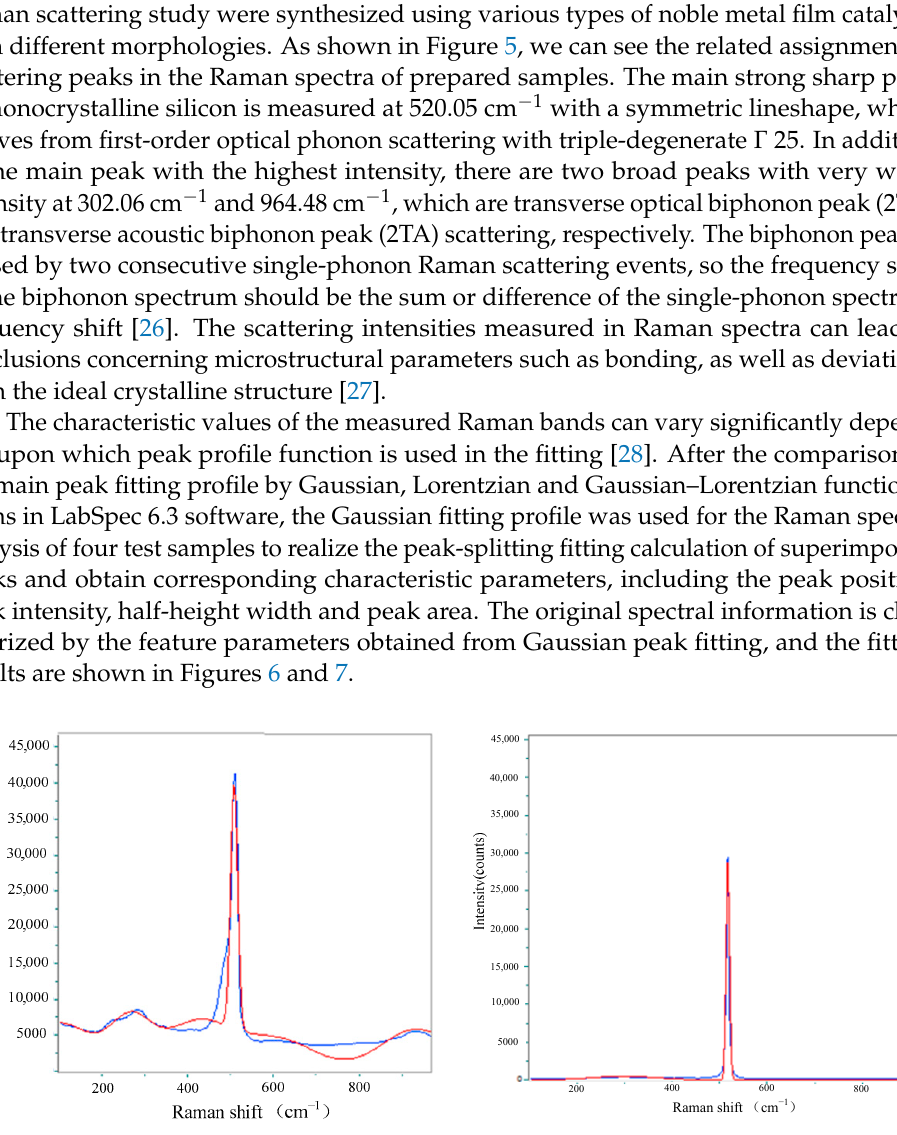
( b ) Figure 7. Gaussian peak fi tt ing diagram of Raman spectra of and ordered SiNWs. ( a ) Before anneal- ing. ( b ) After annealing. In Figure 5, the main peaks around 510.04 cm − 1 (disordered SiNWs without anneal- ing), 516.5 cm − 1 (disordered SiNWs with annealing), 512.18 cm − 1 (ordered SiNWs without annealing) and 518.08 cm − 1 (ordered SiNWs with annealing) move toward lower frequen- cies. Because of fi rst-order optical phonon sca tt ering, the representative Raman peak of monocrystalline silicon appears at 520 cm − 1 . As shown in Figure 4b, the diameter of the annealed nanowire columns is 0.3µm; this value is then substituted into the following formula [29,30]: (1) where d is the diameter of the nanowire columns, B is a constant related to the material, ω b is the crystalline TO peak location of monocrystalline silicon, and ω n is the TO peak location for SiNWs. ω b - ω n is the deviation of the measured SiNW peak location from the monocrystalline silicon peak at 520.05 cm − 1 . We can deduce B = 4496 cm − 1 nm 2 from the integrated Raman sca tt ering peak intensity at 520.05 cm − 1 and at around 518.08 cm − 1 with ordered SiNWs after annealing. We also calculated the estimated value of the diameter of disordered nanowire columns before and after annealing to be 135.553 nm and 223.49 nm, respectively. According to the calculation results, the relationship curve between ω b - ω n and the nanowire columns d is plo tt ed.